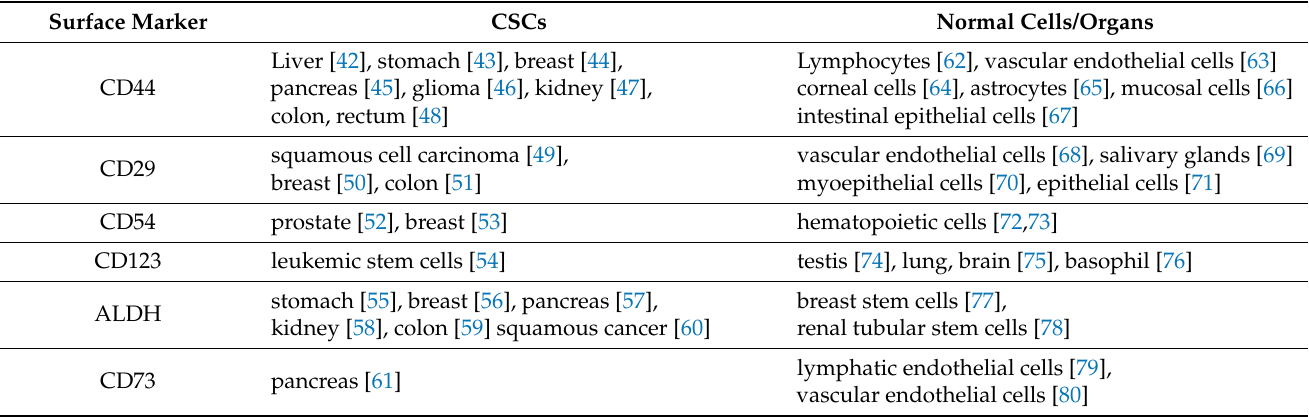
Table 2. Surface markers expressed on the CSCs could also be expressed on the normal organs/cells. Surface